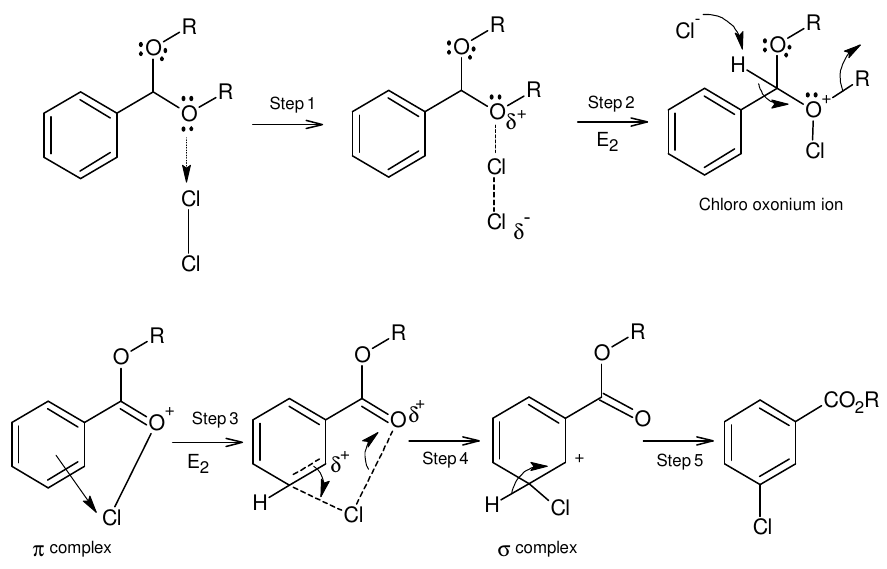
Scheme 1. Mechanism of ring chlorination of acetals by the action of chlorine